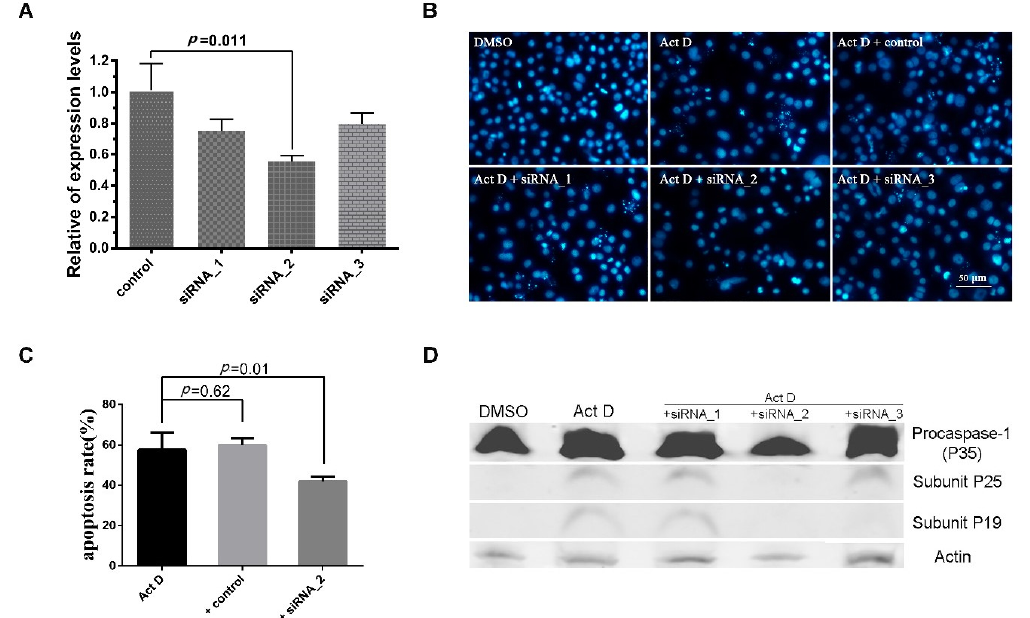
Figure 3. RNAi analysis of the apoptosis activator of Sl-Apaf-1. ( A ) Analysis of the Sl-apaf-1 expression levels by qRT-PCR; ( B ) Microscopic analysis of SL-1 cells; ( C ) FACS analysis of SL-1 cells treated with Act D; ( D ) Western blot analysis of Sl-caspase-1 activation. Original Western blot see Figure S5.